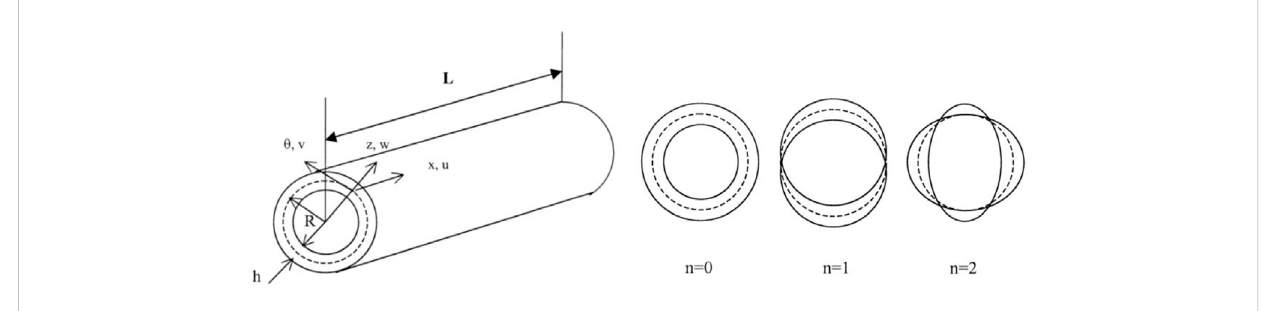
FIGURE 2 Coordinate system and circumferential modal